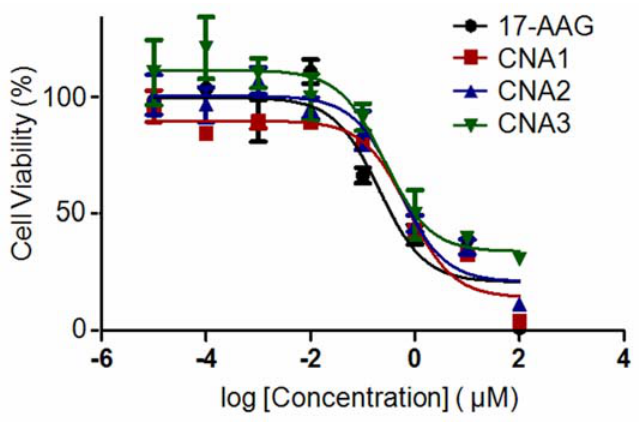
Figure 5. Viability curves of A549 cells exposed to CNAs entrapping